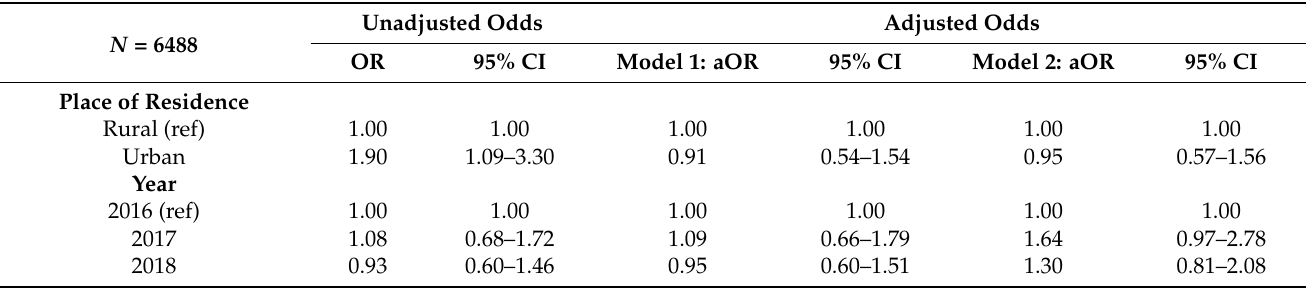
Table 4. Weighted crude and adjusted odds of intrauterine device (IUD) use among Nigerian women aged 15–49 using